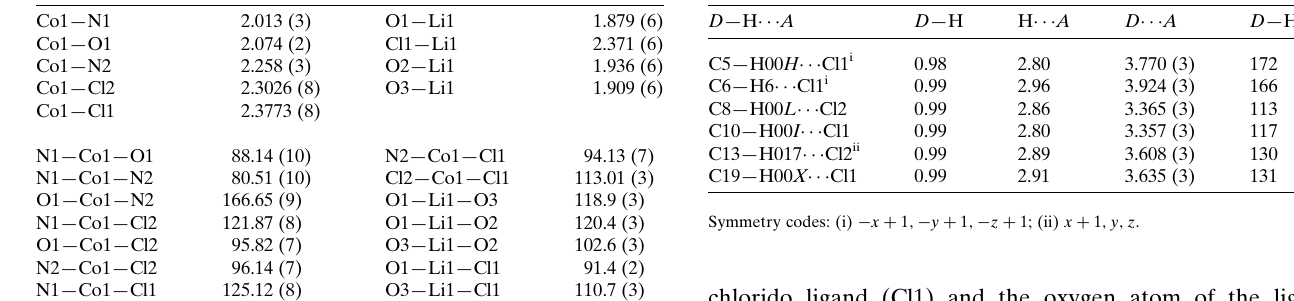
Table 1 Selected geometric parameters (A˚ , (cid:4) ).